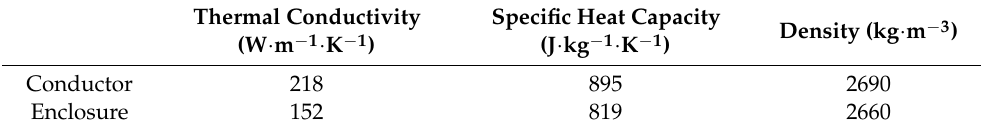
Table 2. Thermal parameters of the conductor and